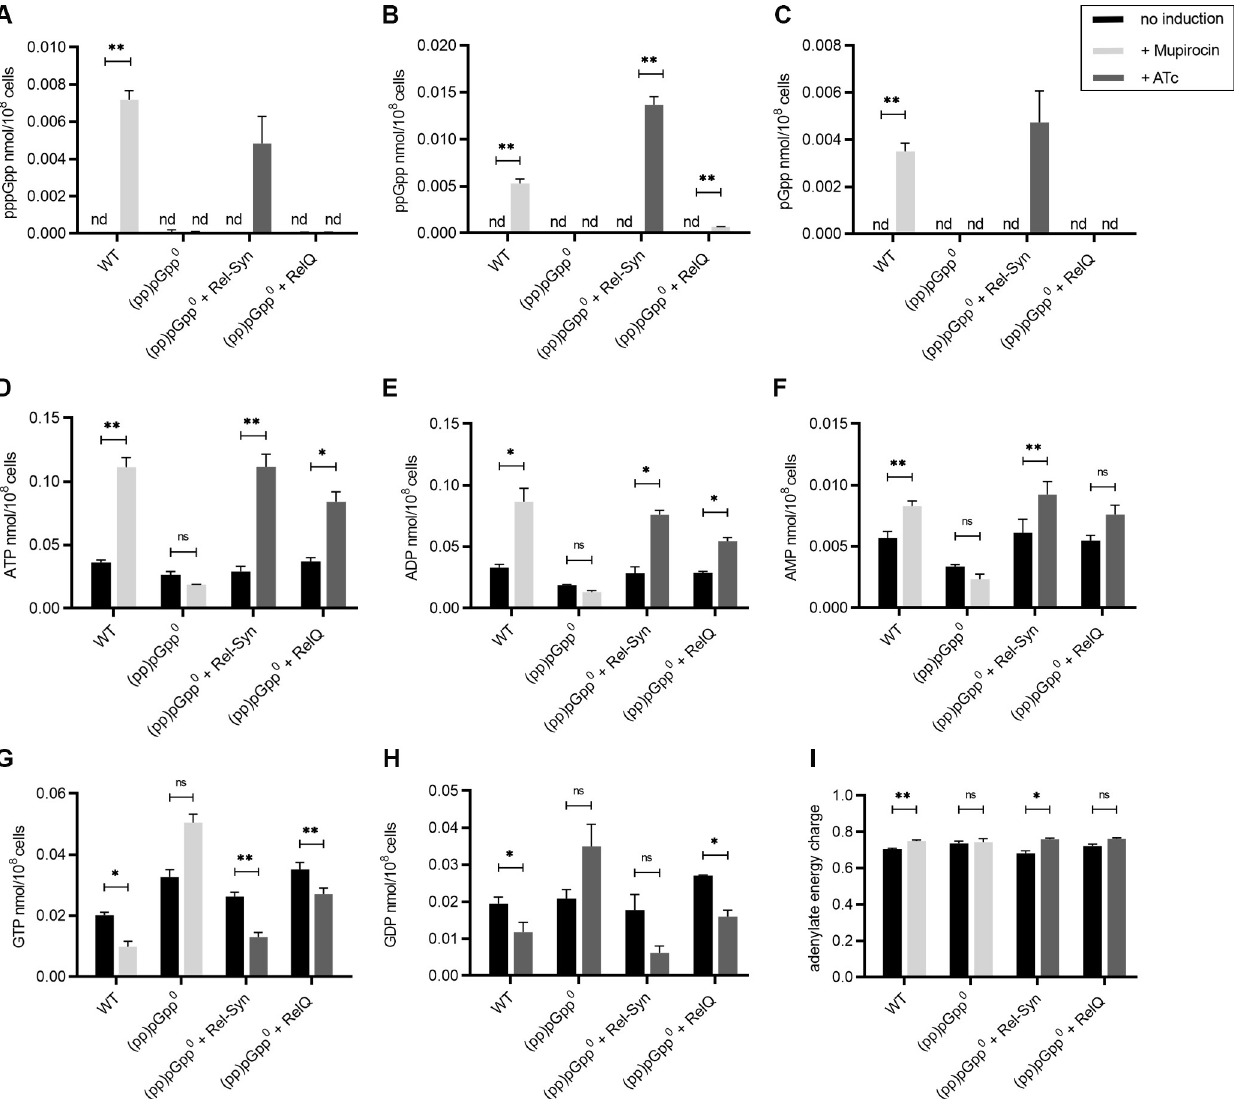
Fig 1. Changes in the nucleotide pool after mupirocin treatment or transcriptional induction of rel-Syn or relQ . Strain HG001 and derivatives were grown to OD 600 = 0.3 and treated for 30 min with or without 0.125 μ g/ml mupirocin (lightgrey) or 0.1 μ g/ml ATc (darkgrey). Nucleotide analyses were performed using mass spectrometry (ESI-TOF) in negative ion mode. Error bars represent SEM (n = 3) from three biological replicates. The adenylate energy charge was calculated by [ATP] + 0.5 [ADP]/[ATP] + [ADP] + [AMP]. Statistical significance was determined by two-tailed Student´s T-test, � p � 0.05, �� p � 0.01, ��� p � 0.001 and ���� p � 0.0001.